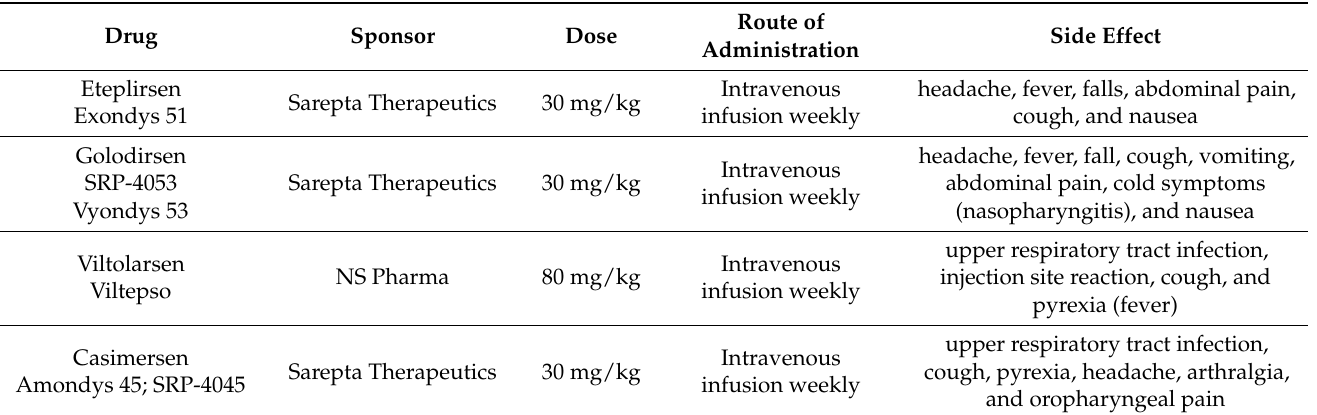
Table 3. Features and properties of exon skipping drugs in